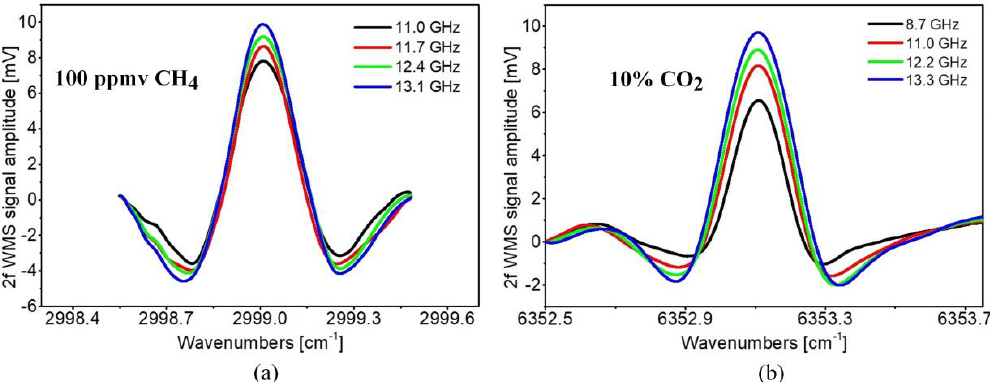
Figure 6. 2f wavelength modulation spectroscopy (WMS) signal spectra retrieved for